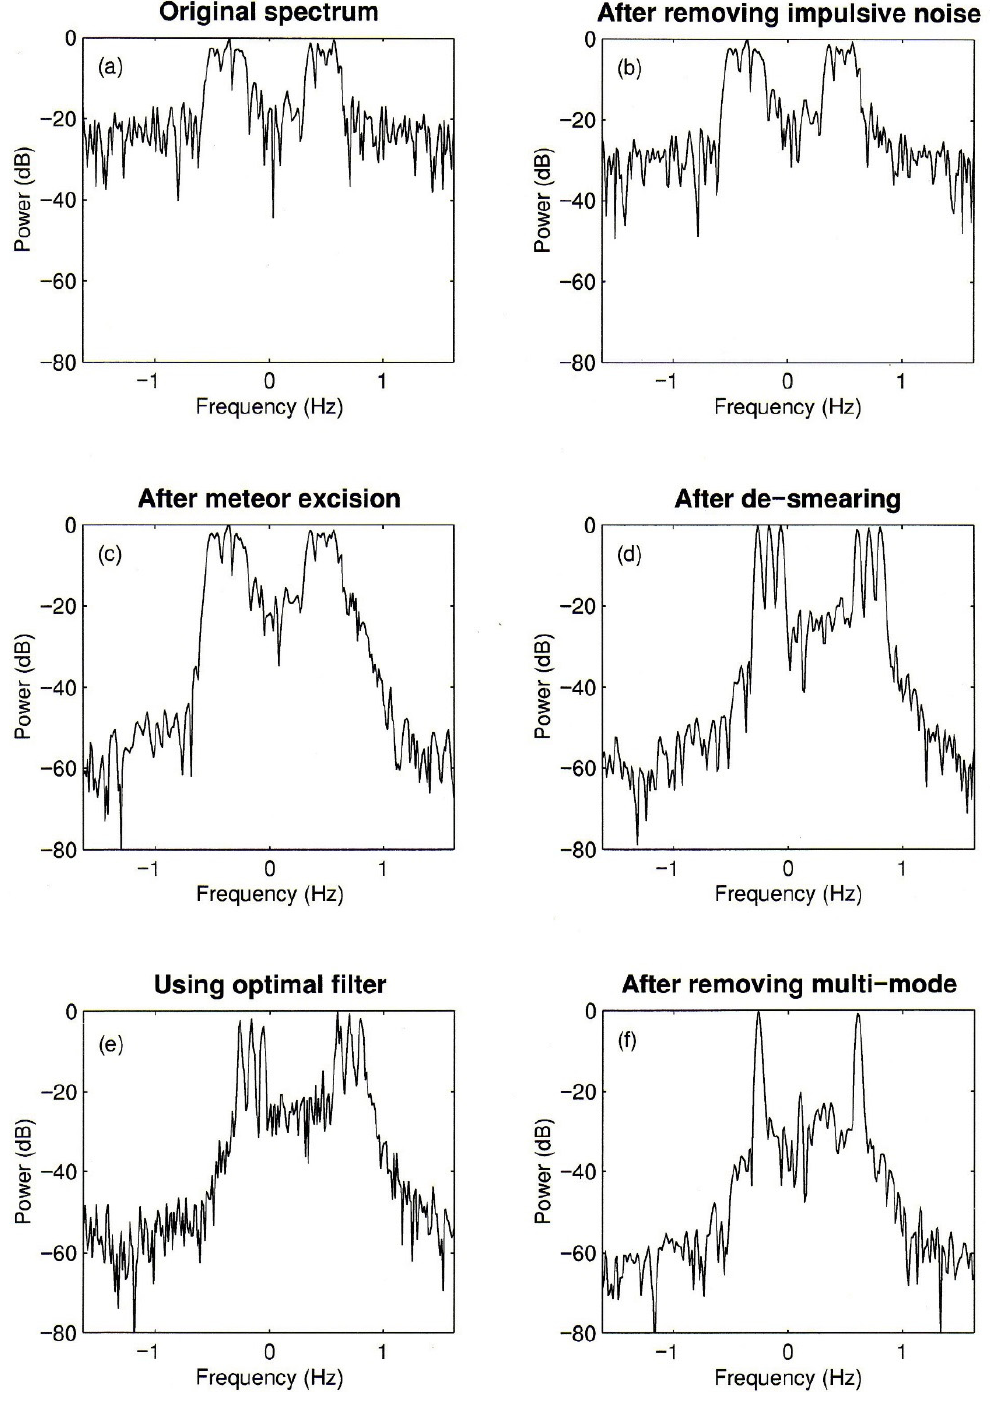
Figure 21. Progressive clean-up of skywave radar sea clutter that has experienced the most common forms of contamination and distortion. The progressive signal processing measures are indicated in the titles of the individual panels ( a – f